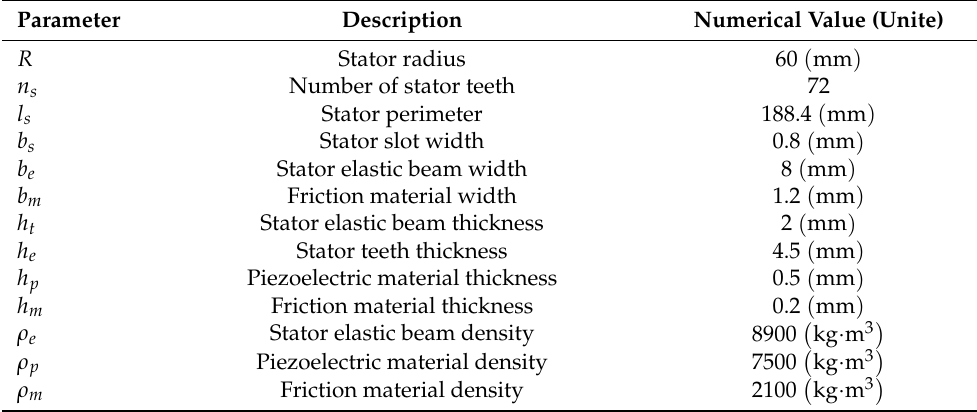
Table 1. The simulation parameters of